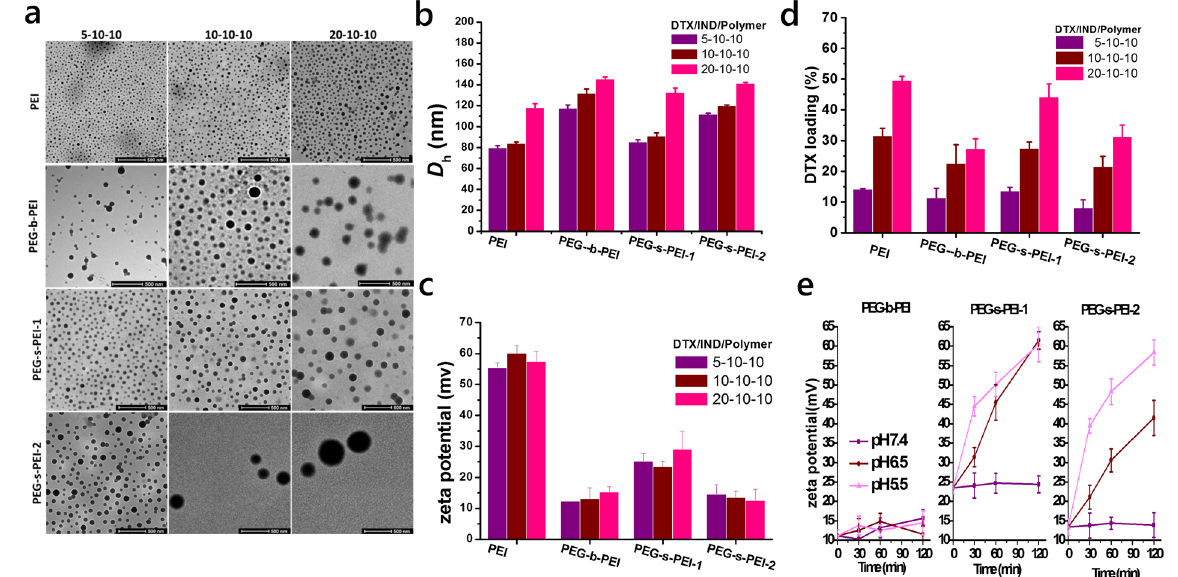
Figure 3. Characterization of physicochemical properties of NAs formed by DTX,IND and Polymers at various weight ratios. ( a ) TME images. ( b ) Hydrodynamic diameter ( D h ). ( c ) ζ -potential. ( d ) DTX loading contents in NAs. ( e ) Changes in ζ -potential in various PBS buffers at pH 7.4, 6.5 and 5.5.